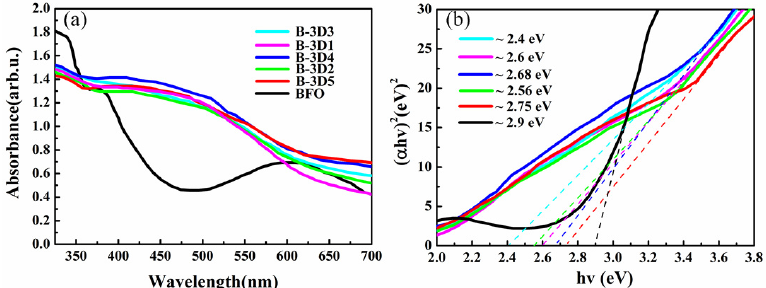
Figure 6. UV—vis absorption spectra ( a ) and corresponding ( α hv ) 2— hv curves ( b ) of 3D BFO/graphene composites. Table 1. The band gaps of 3D BFO/graphene composites.